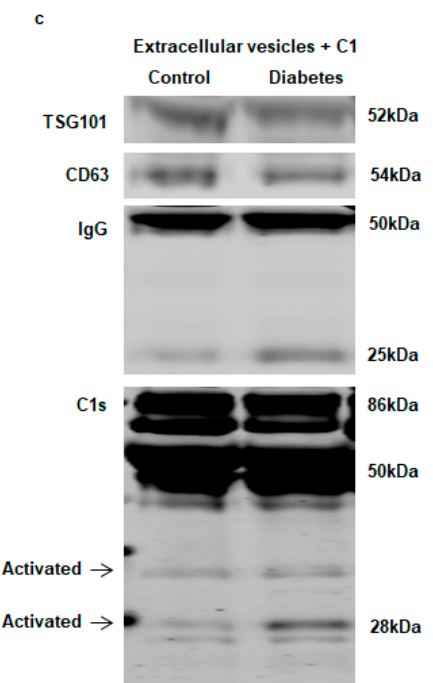
Figure 3. Comparison of rat artery plasma extracellular vesicles isolated via ExoQuick from control and STZ-induced diabetic (7 weeks) rats. ( a ) The number of vesicles was increased significantly in diabetic (7 weeks) rat plasma than in control. The number of vesicles isolated from plasma of control rats (circles) and STZ-induced diabetic rats (squares) was measured through the use of SLS (kilocounts per second). ( b ) Dynamic light scattering (DLS) measurement showed an increase of diameter in diabetic vesicles (squares) compared with control (circles). n = 10 for control and diabetes, ** p < 0.05. ( c ) Western blot of artery plasma vesicles isolated through the use of ExoQuick from control and STZ-induced diabetic (7 weeks) rats. Under condition of equal volume loading, extracellular vesicle markers (TSG 101 and CD63) show no difference between combined control and diabetic plasma vesicles; however, an increased amount of IgG was observed in diabetic rat plasma, but not with control rat plasma. Moreover, diabetic rat artery plasma vesicles had higher C1 activity than control vesicles.